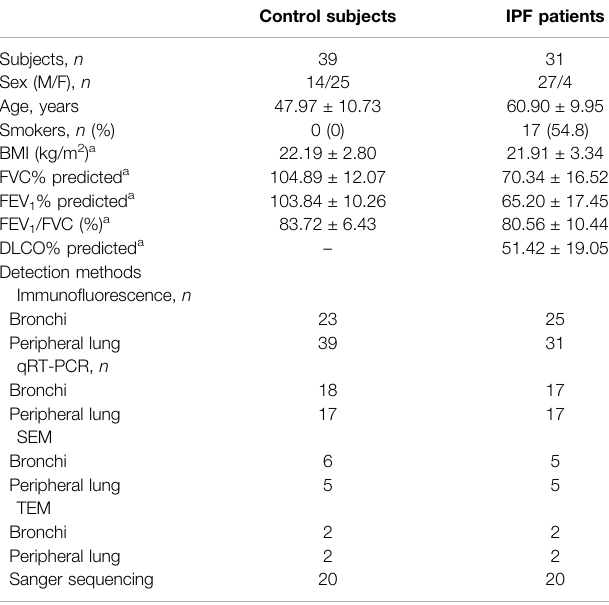
TABLE 1 | Baseline characteristics of study